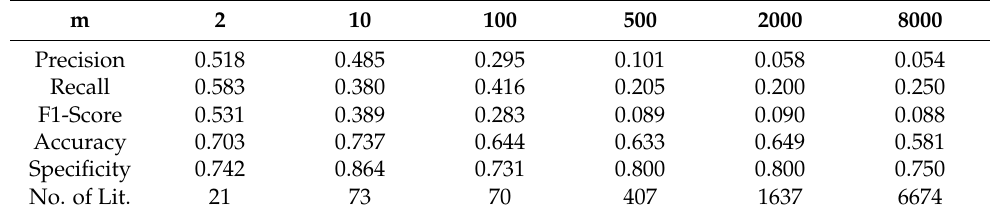
Table 14. Performance of TM with Booleanized continuous features on Breast Cancer dataset.